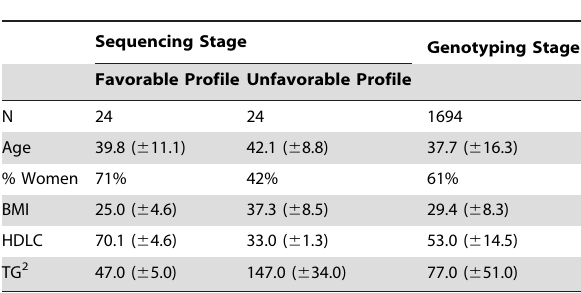
Table 1. Participant characteristics 1